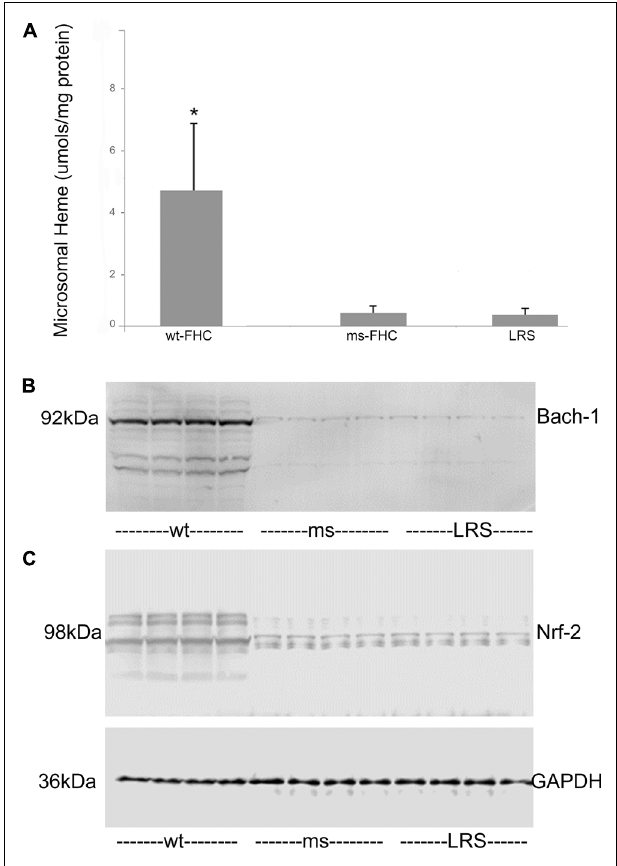
FIGURE 4 | Liver heme content and nuclear Nrf-2 and Bach-1 levels are elevated in sickle mice expressing human wt-FHC. (A) The heme content of liver microsomes from sickle mice treated with wt-FHC, ms- or LRS was determined by the pyridine hemochromogen method ( n = 4).Values are means ± SD, * p < 0.05 by one-way ANOVA for wt-FHC vs. other groups. Nuclear extracts were isolated from livers, and 30 μ g of nuclear extract protein from each liver was run on a western blot and immunostained for Bach-1 (B) and Nrf-2 (C) .The GAPDH loading control at the bottom applies to both (B) and (C).